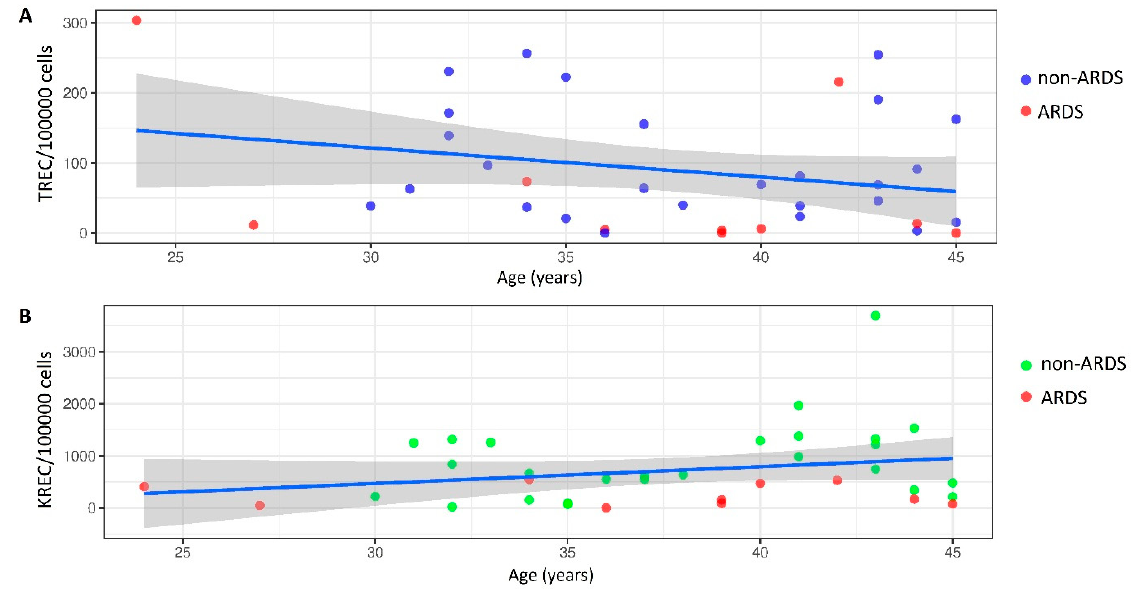
Figure 2. Linear regression analysis of age and TREC/KREC in ARDS and non-ARDS patients: ( A ) TREC; ( B ) KREC.